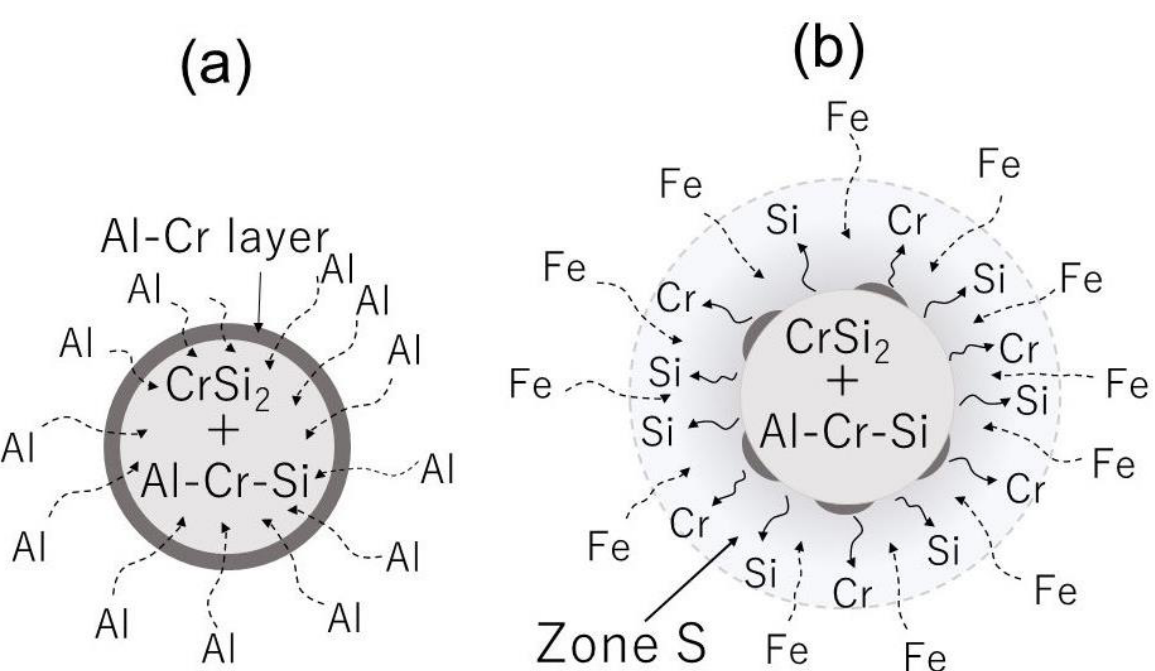
Figure 1. Schematic representation of CrSi 2 particles in master alloy ( a ) and ( b ) particle dissolution in Al-Fe-Si melt.